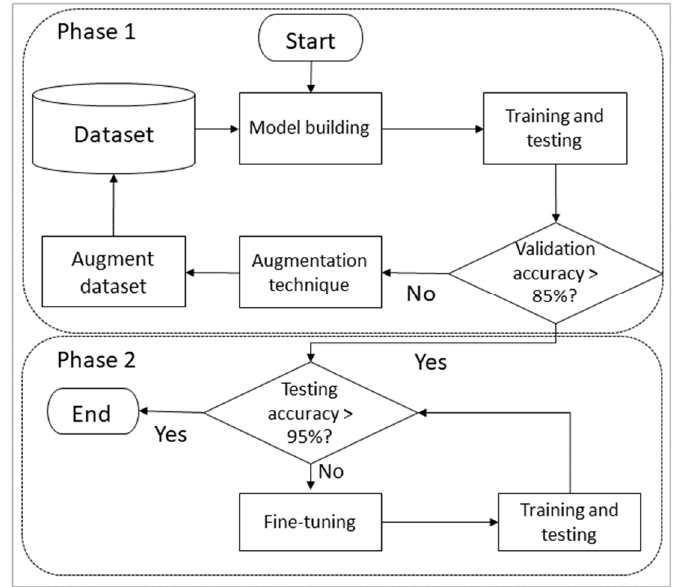
Figure 1. A two-phase approach of developing a CNN model for classifying Arabic short vowels.